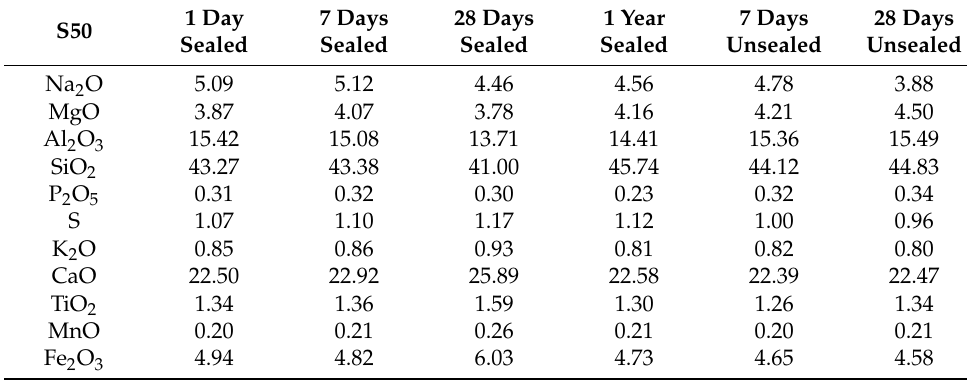
Table 9. Bulk chemistry obtained with XRF for the paste